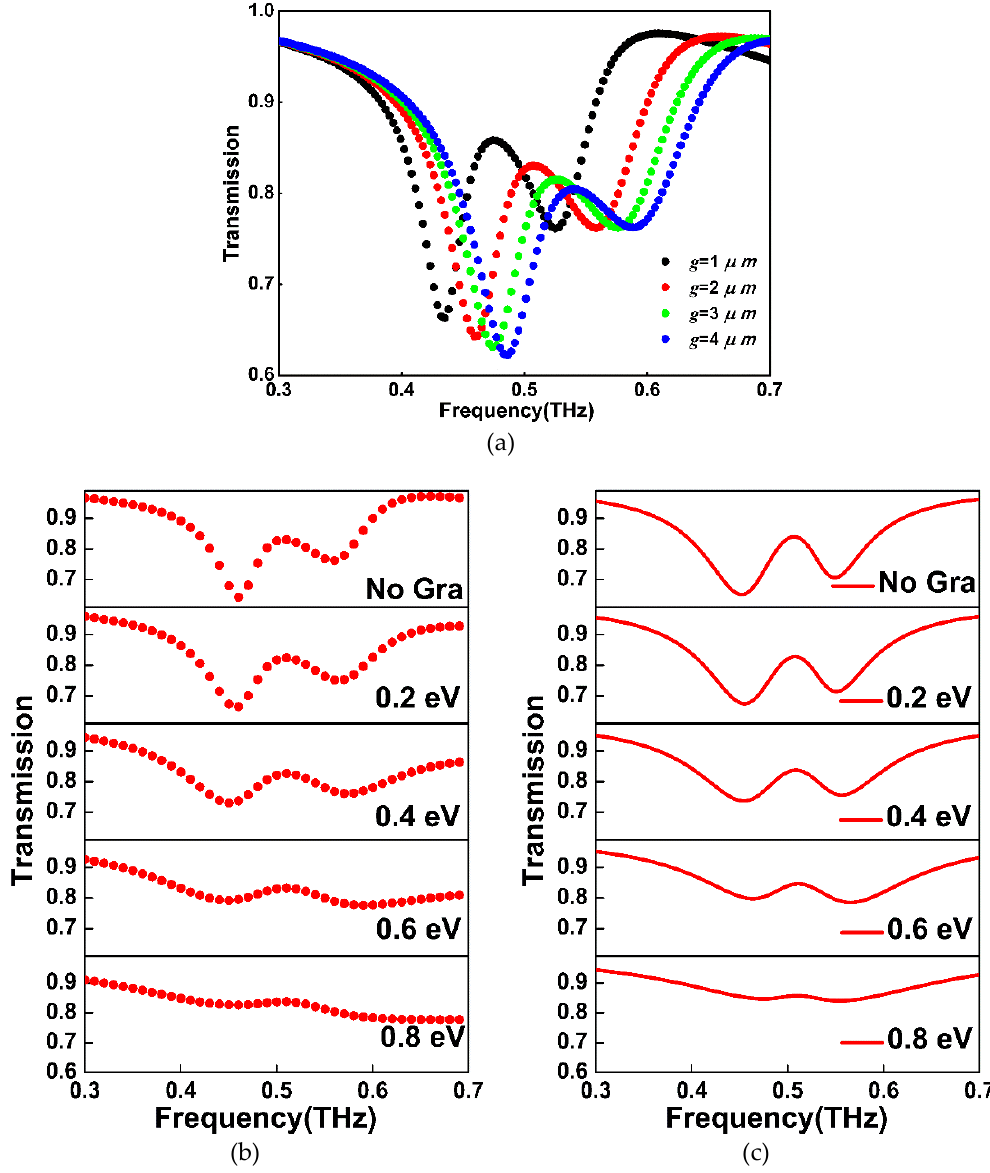
Figure 3. The tunable transmission spectra for the proposed PIT metamaterial: ( a ) with di ff erent gaps g = 1, 2, 3, 4 µ m; ( b ) numerical simulation and ( c ) analytical calculation for di ff erent Fermi energies.